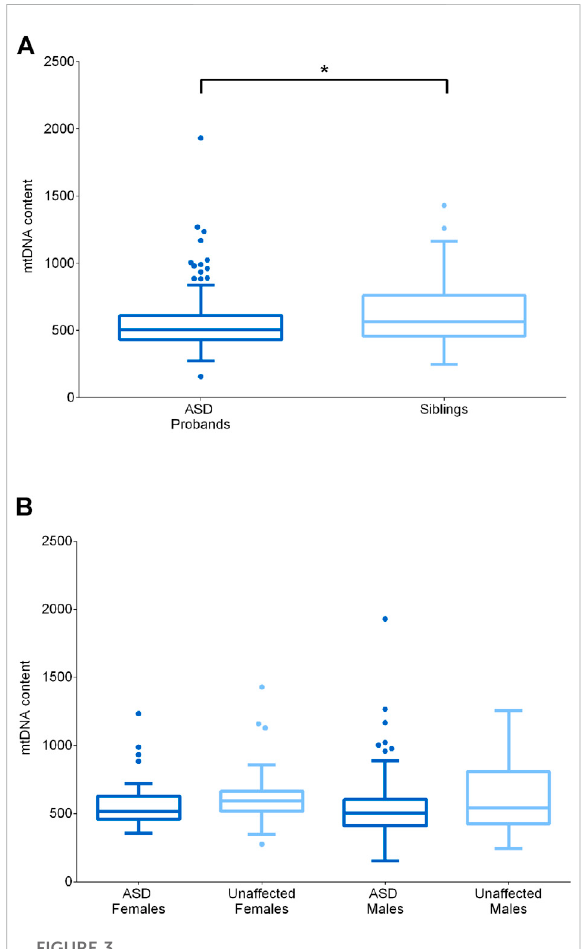
FIGURE 3 MtDNA content assessment in ASD probands and their unaffected siblings. (A) MtDNA content in ASD probands (n = 109, median=505)andtheirunaffectedsiblings(n=51,median=564). (B) MtDNA content in unaffected females (n = 24, median = 595),ASDfemales(n=23,median=514),unaffectedmales(n=27, median = 542) and ASD males (n = 86, median = 504). Data are shown as Tukey box and whiskers plot. * indicates statistical signi fi cance ( p -value < 0.05), as calculated by the Mann-Whitney U